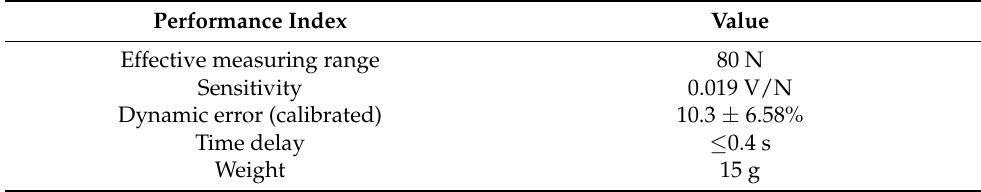
Figure 10. Step loading force test at different initial inflation pressures. The loading forces were given by an electric cylinder loading test bench. Table 1. Performance of the developed soft sensor system for force